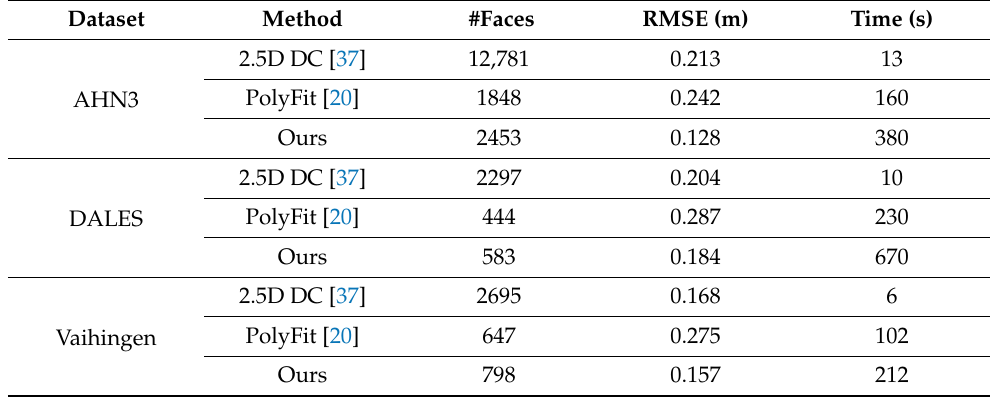
Figure 8. Comparison with 2.5D Dual Contouring (2.5DC) [37] and PolyFit [20] on a single building from the AHN3 dataset [21]. Table 2. Statistics on the comparison of 2.5D Dual Contouring [37], PolyFit [20], and our method on the reconstruction from the AHN3 [21], DALES [52], and Vaihingen [53] datasets. Total face numbers, running times, and average errors are